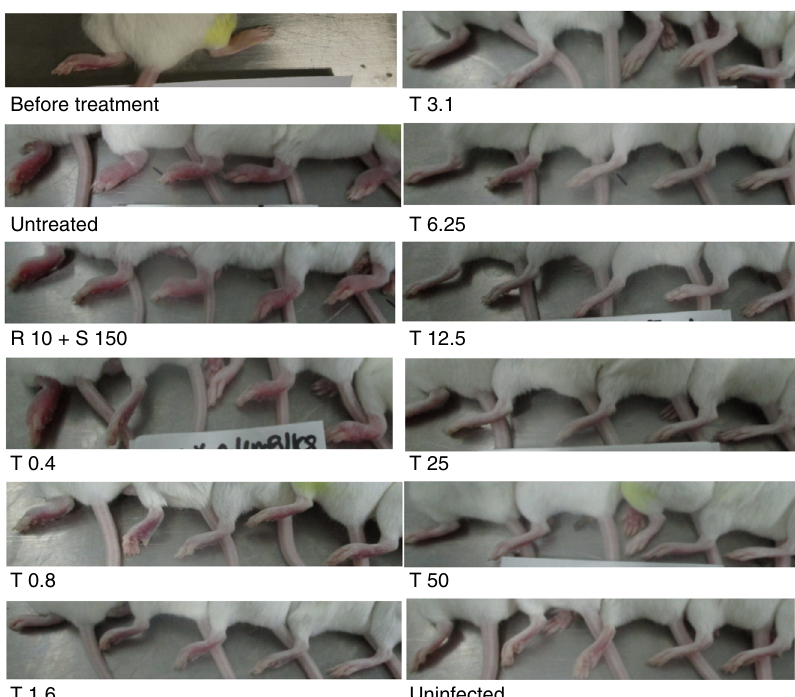
Fig. 2 Photographs showing the swelling degrees of the left hind mouse footpads at 0 and day 7. The ALI is 3 ± 0, 2.8 ± 0.27, and 1.8 ± 1.25, for the untreated, rifampin + streptomycin and T0.4, respectively. Only one obvious swelling footpad (swelling index about 2) was observed in the T0.8 mg kg − 1 group (the left one) and one questionable swelling footpad in the T0.8 mg kg − 1 group (the middle one) and no any swelling footpad (ALI = 0) was observed in any groups treated with T ≥ 3.1 mg kg − 1 . T, TB47; R, rifampin; S, streptomycin. Dosage, mg kg −